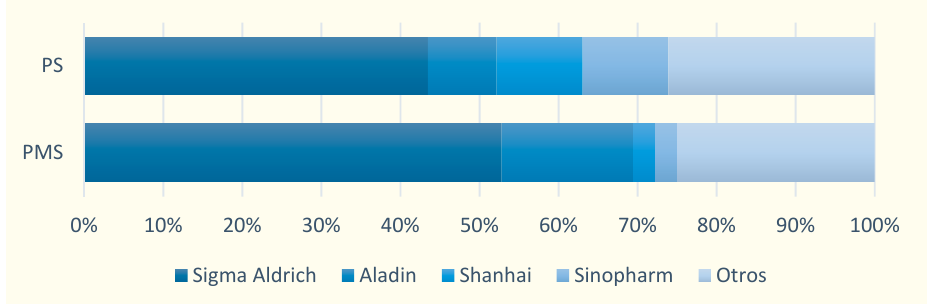
Figure 2. PMS and PS suppliers and market share.